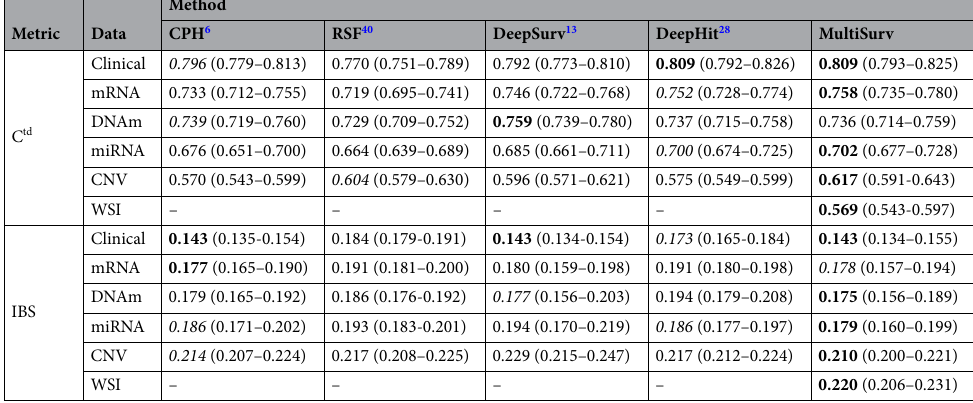
Table 1. Method performance with unimodal data inputs. CPH Cox proportional hazards, RSF random survival forest, Clinical tabular clinical data, mRNA gene expression, DNAm DNA methylation, miRNA microRNA expression, CNV gene copy number variation, WSI whole-slide images. Time-dependent concordance index (C td ) and integrated Brier score (IBS) with 95% bootstrap confidence interval (CI; numbers in parentheses). The best and second best results for each metric for each data modality are boldfaced and italics, respectively.